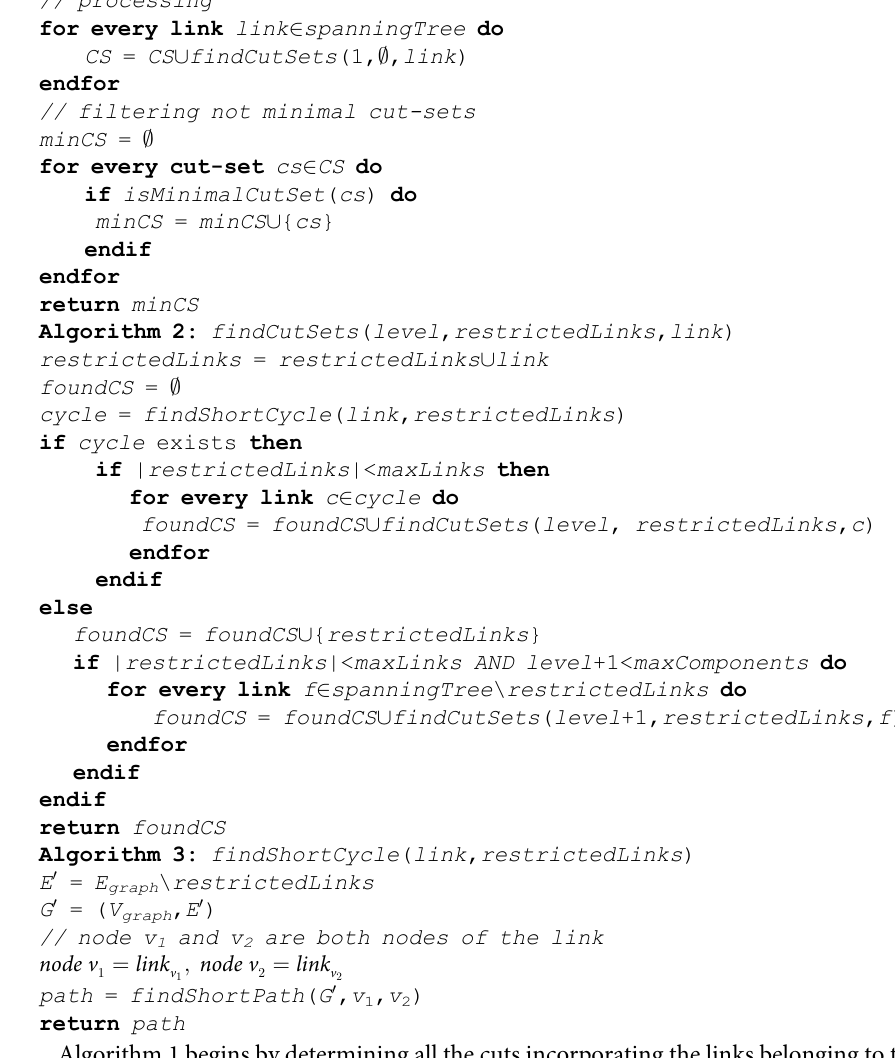
Algorithm 2: findCutSets ( level , restrictedLinks , link )